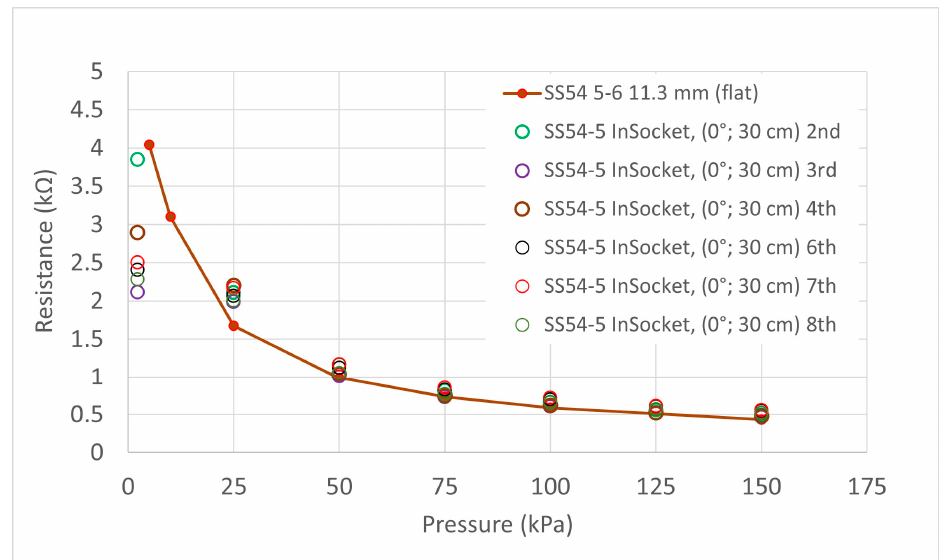
Figure 18. Graph showing in-socket measurement for SS54 Sensel 5 on an area in the socket with a large curvature. The red line curve shows the results obtained for the same sensel on a flat surface